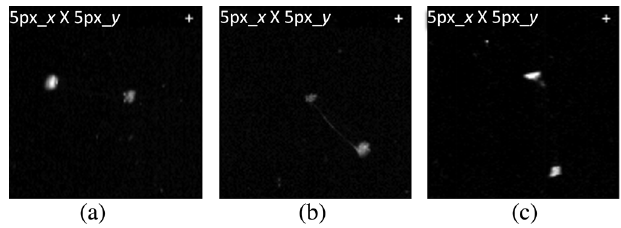
FIG. 13. Detail of three fibers as seen through optical filters; only the dyed edges are visible. A threshold of 5 by 5 pixels in the x and y directions, as indicated in the upper left corner of the panels, is imposed on the pixel cluster size to exclude dust or small residual